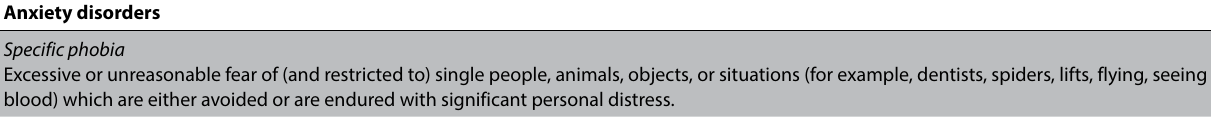
Table l: Summary of the classification and main characteristics of the anxiety disorders, obsessive compulsive disorder and post-traumatic stress disorder 2,7 Anxiety